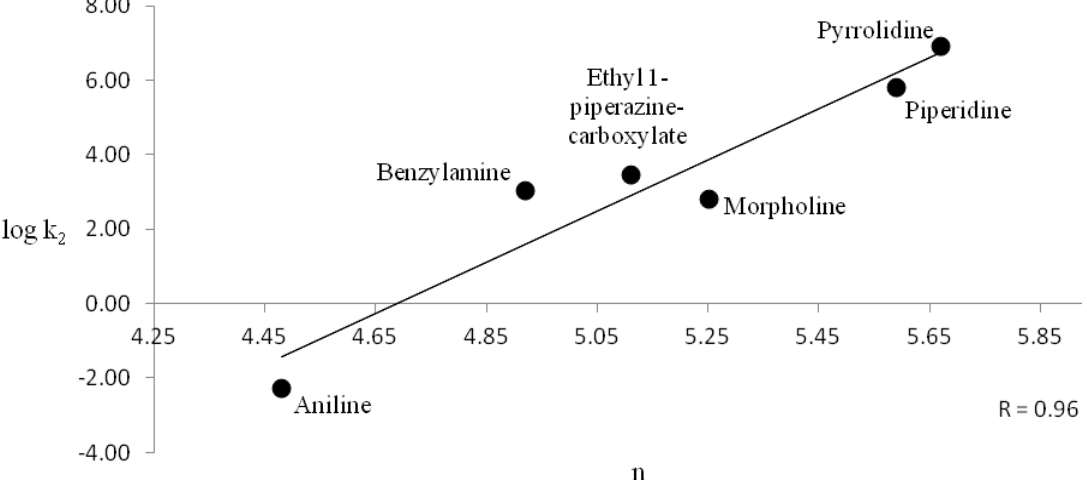
Figure 4. Swain-Scott nucleophilicity n vs . log k